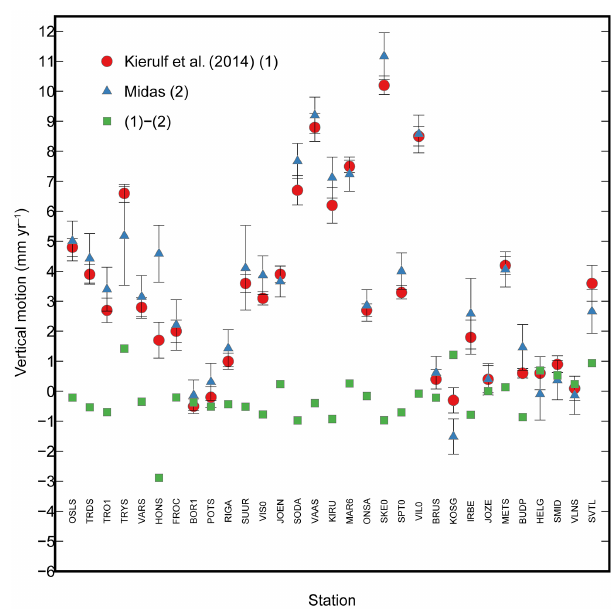
Figure A1. Vertical land motion measurements at 31 sites common to both datasets used in this study.